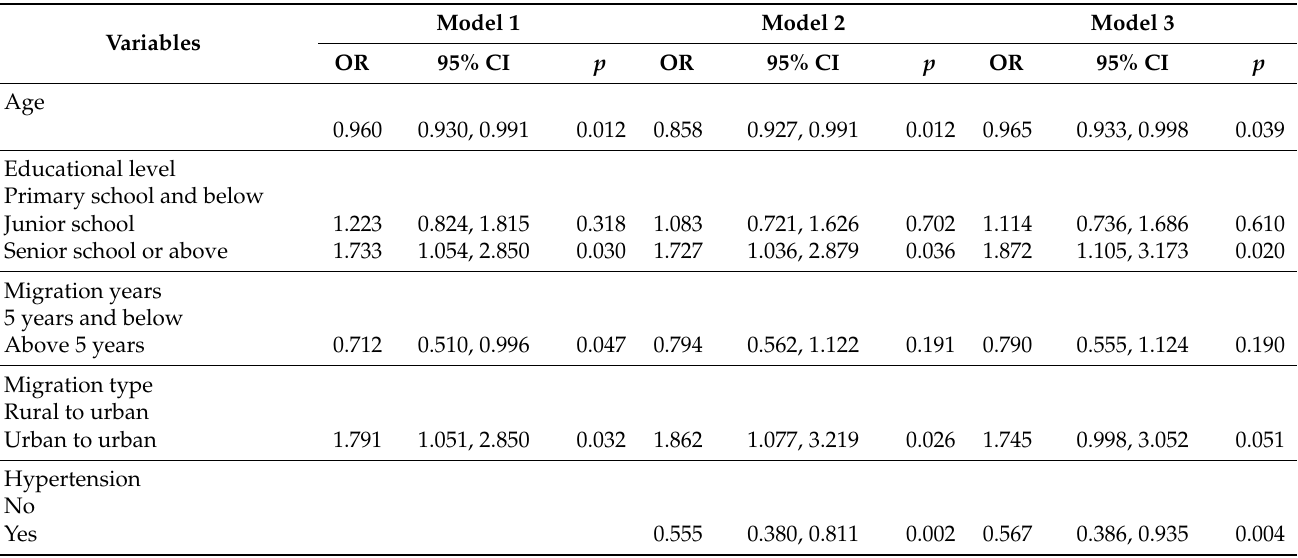
Table 4. Binary logistic regression of demographic characteristics, morbidities, depression, anxiety, stress, and GOHAI of the